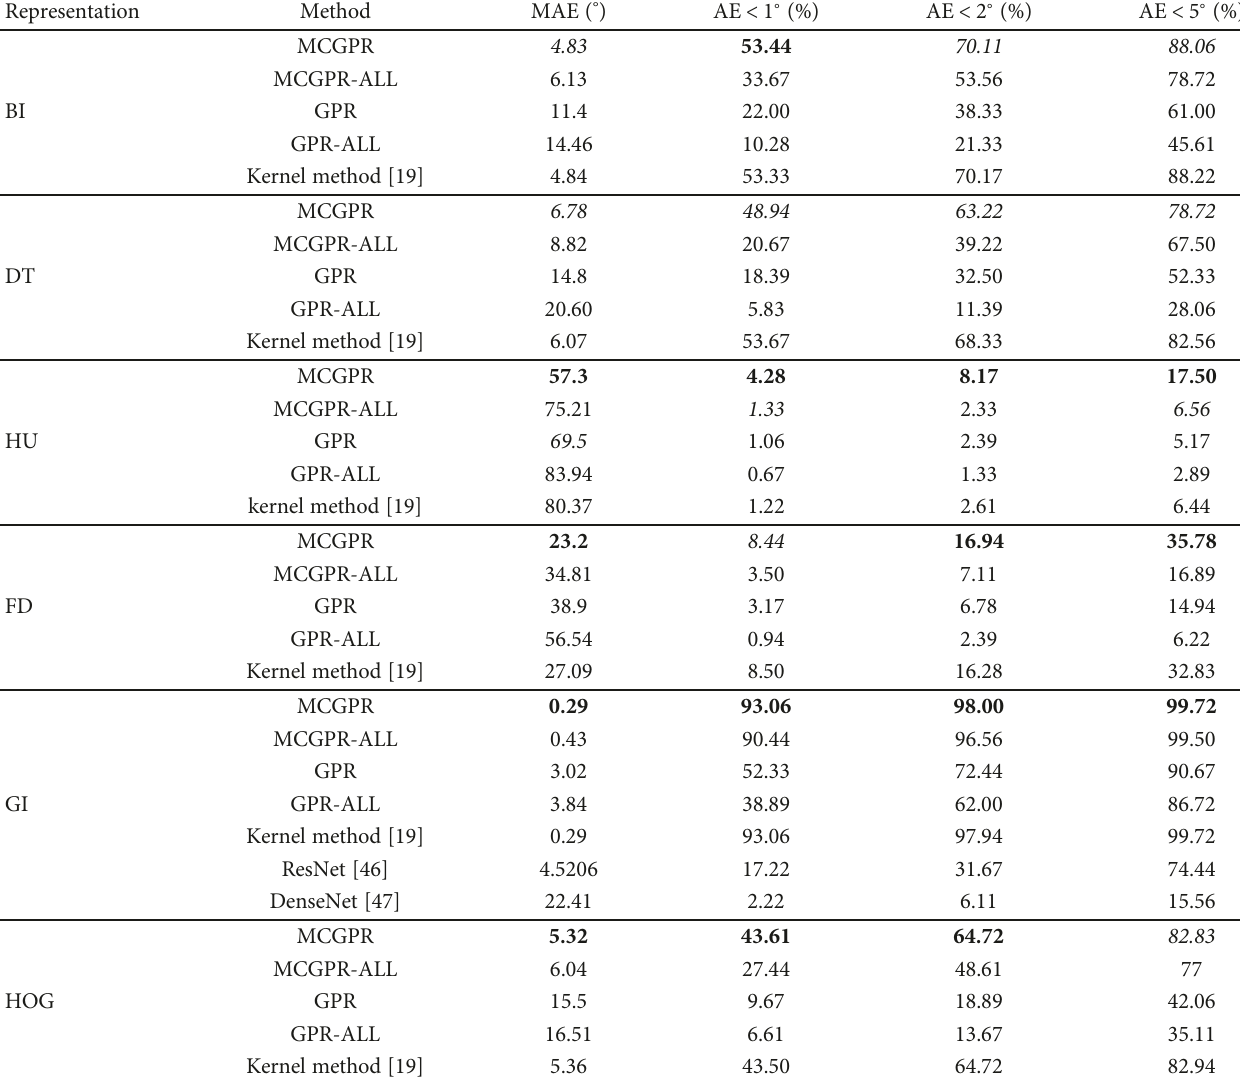
Table 5: Pose estimation results on the 1D subset of BUAA-SID 1.5. Results are in bold if the proposed method performs the best and in italic if the second